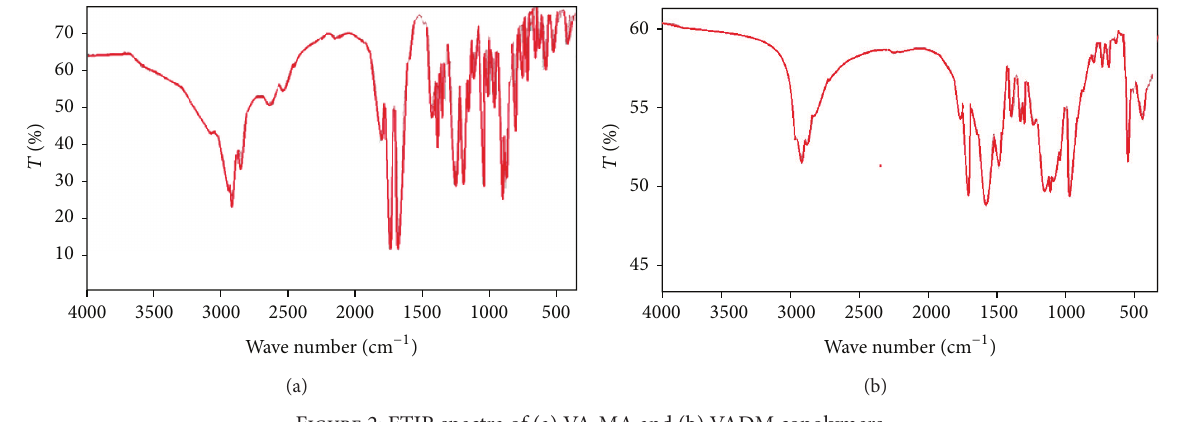
Figure 2: FTIR spectra of (a) VA-MA and (b) VADM copolymers.